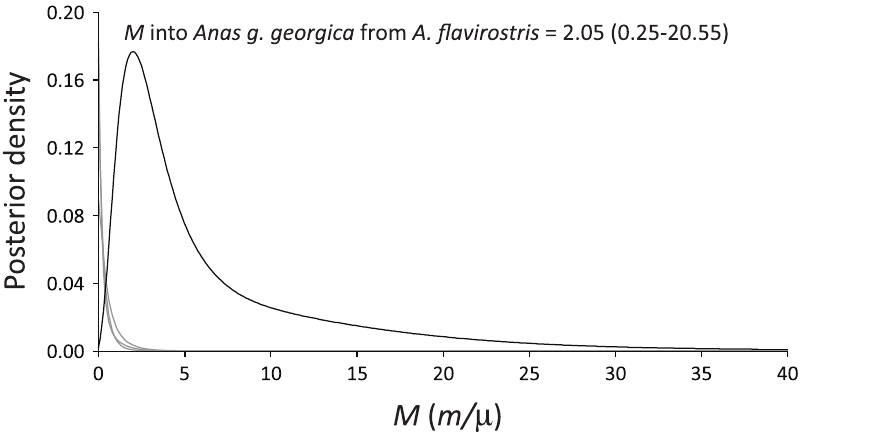
Figure 4. Gene flow estimates and the 95% highest posterior density (HPD) for nuclear DNA from the three-population IMa2 analysis between pintails and speckled teal. Gene flow from speckled teal into the South Georgia pintail population was positive. All other between-species gene flow parameter estimates peaked at zero.